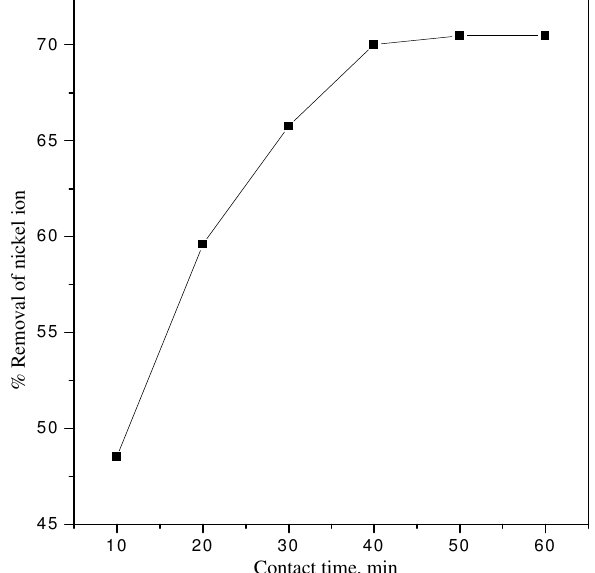
Contact time in min Figure 1 . Effect of contact time on the adsorption of nickel